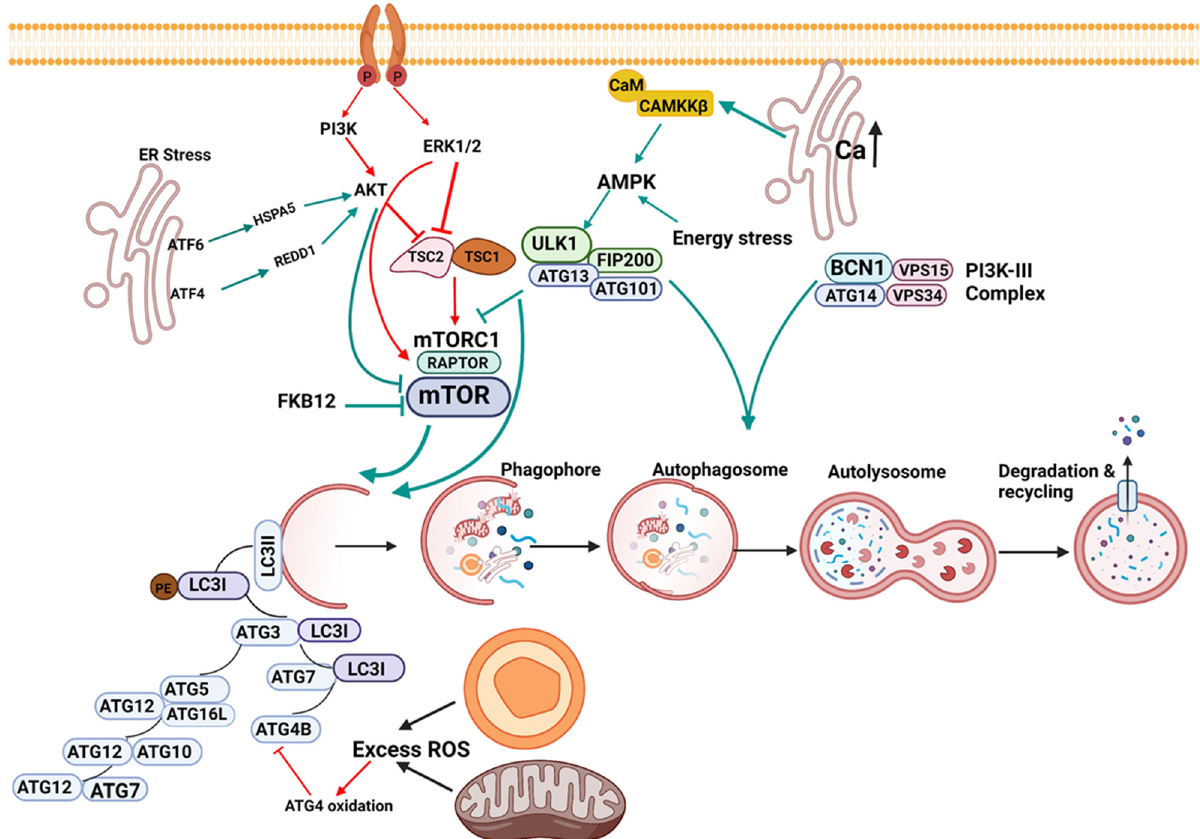
Figure 1. Signaling in macroautophagy. The figure depicts some of the prominent signaling pathways of autophagy. The activation of the PI3K/AKT/ERK1/2 kinases promotes the phosphorylation and activation of the mTOR pathway, thereby inhibiting autophagy. AKT activates mTOR by directly phosphorylating and inhibiting TSC2. ERK phosphorylates and functionally inactivates TSC2. ERK can also phosphorylate raptor of the mTORC1 complex and promote the activation of mTOR (red arrow). An increase in calcium within the ER, calmodulin-binding, and stress conditions such as amino acid starvation activates CAMKK β , which activates AMPK. Energy stress is well known to activate AMPK. AMPK activates ULK1, a mammalian autophagy initiating kinase, which leads to the inhibition of mTORC1, leading to the activation of autophagy (green arrows). In addition, ULK1 can phosphorylate Beclin-1 in association with ATG14 to promote